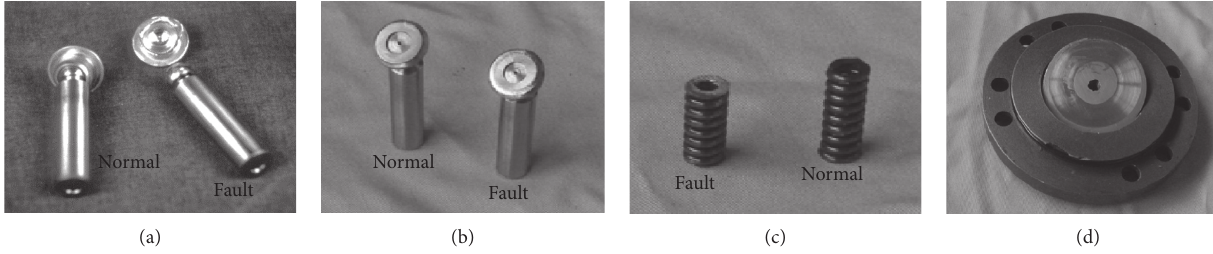
Figure 9: Some pictures of the fault elements. (a) Single slipper off fault. (b) Single slipper wear fault. (c) Center spring fault. (d) Swash plate wear fault.